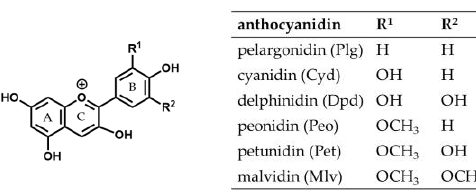
Figure 1. Structure of the six most frequently occurring anthocyanidins.